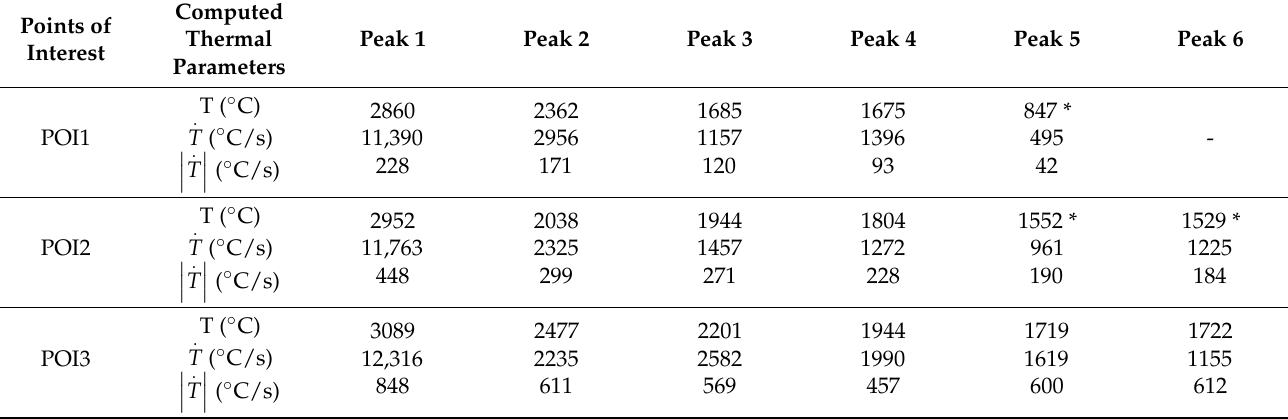
Table 3. FE predicted main peak temperatures, heating ( points of interest (POIs).